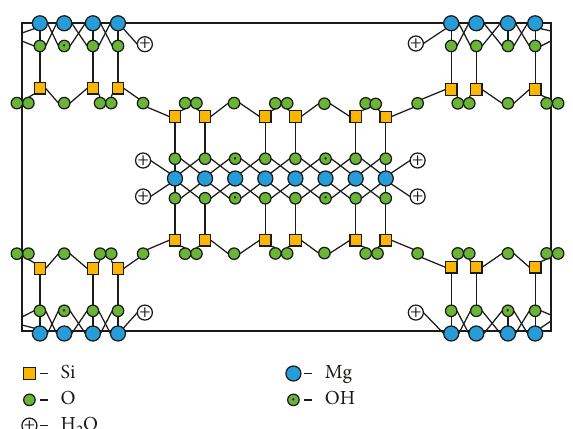
Figure 2: Projection of sepiolite unit cell on the (001)